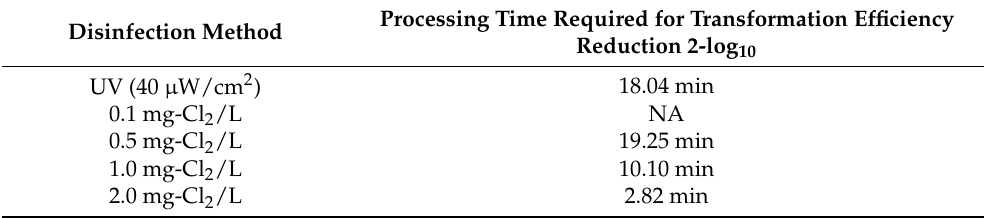
Table 2. Processing time required to reduce the 2-log 10 transformation